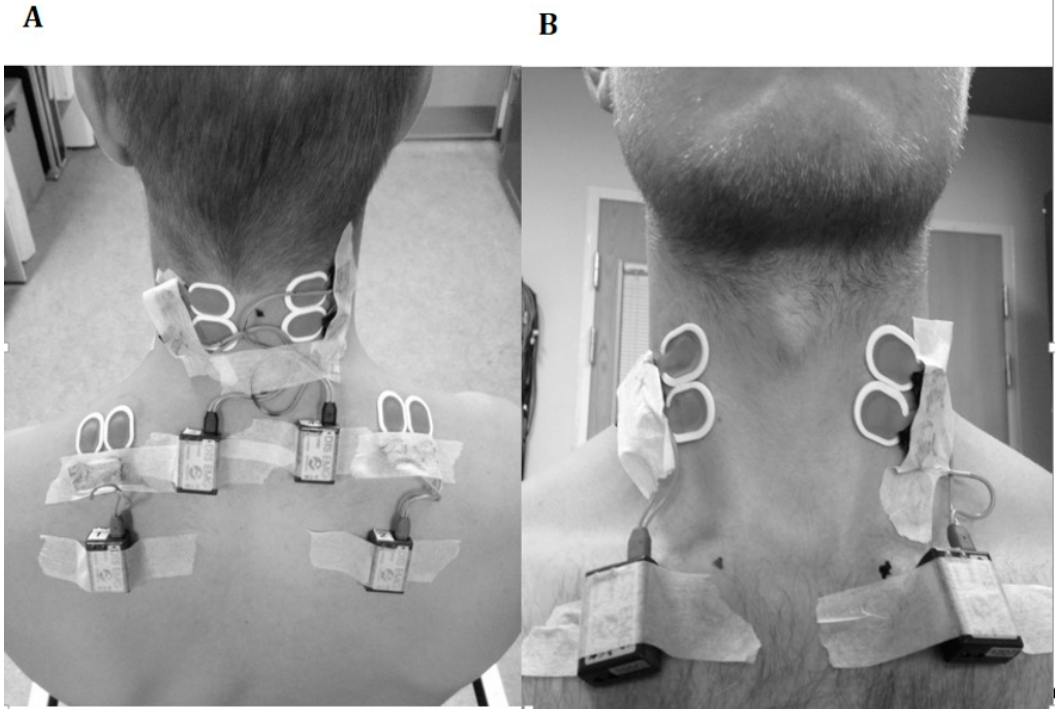
Figure 1. Bilateral electrode placement above the upper trapezius muscle (mUTR) and upper neck extensors muscles (mUNE) ( a ) and sternocleidomastoideus muscles (mSCM) ( b ).